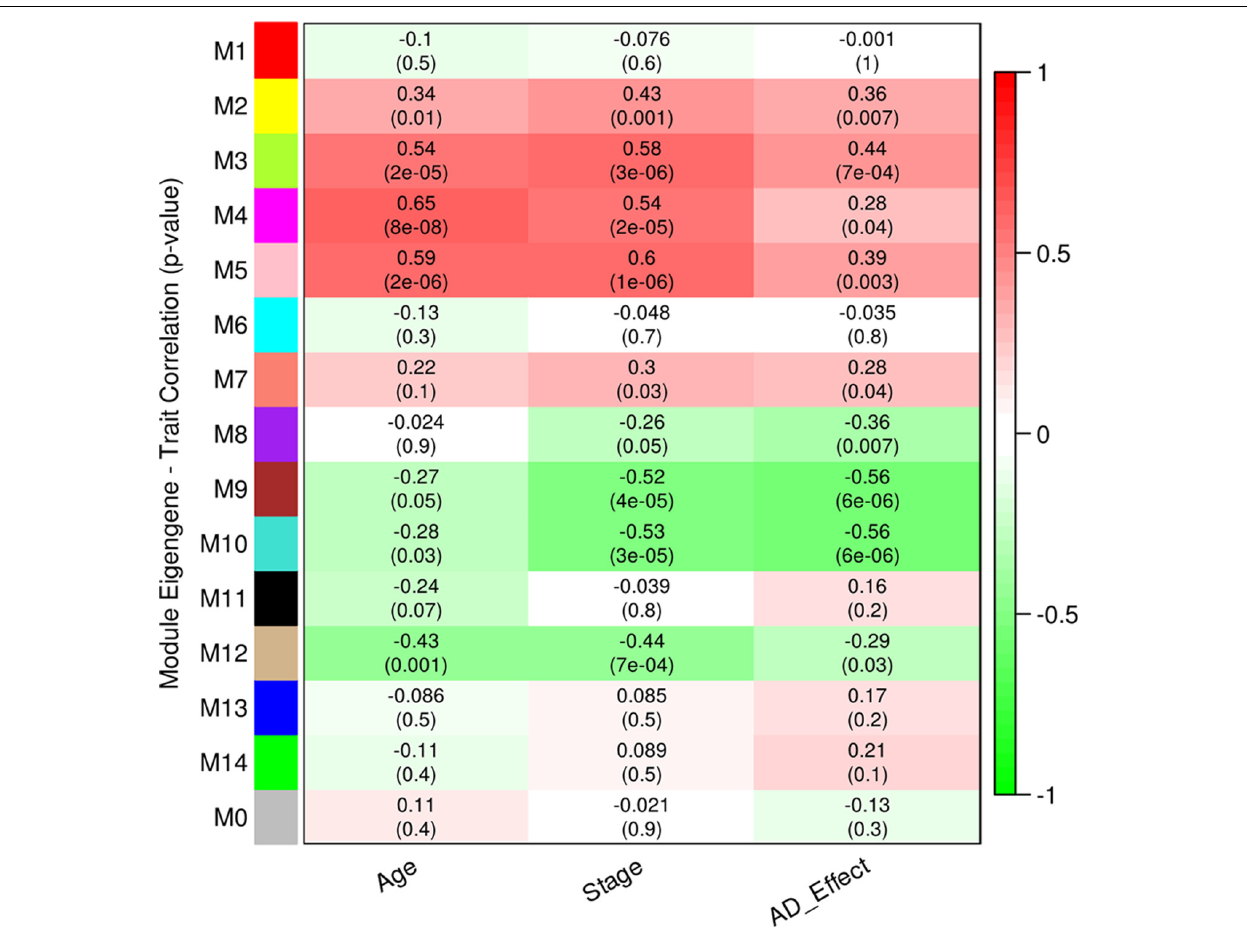
FIGURE 2 | Correlation between module eigengene (ME) expression value and age, stage (0-young, 1-aging, 2-AD), AD (young and aging-0, AD-1) for each module. Pearson correlation is reported with the p -value given inside the bracket.